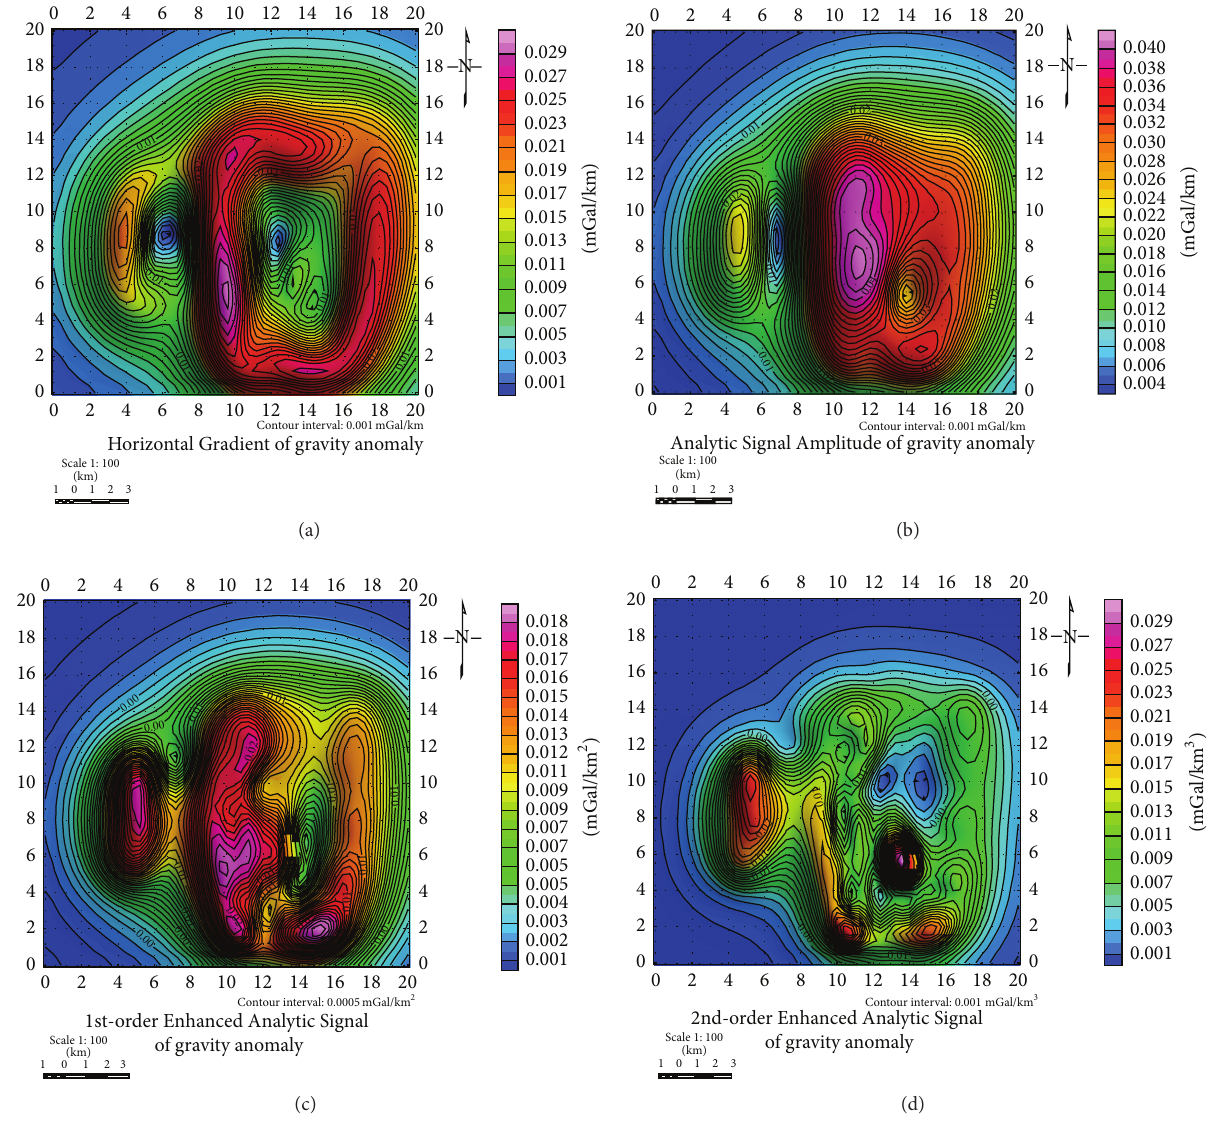
Figure 5: Lateral extent of source bodies from a set of depth-to-source estimation methods. (a) Horizontal Gradient, (b) Analytic Signal Amplitude, (c) 1st-order EAS, and (d) 2nd-order Enhanced Analytic Signal.